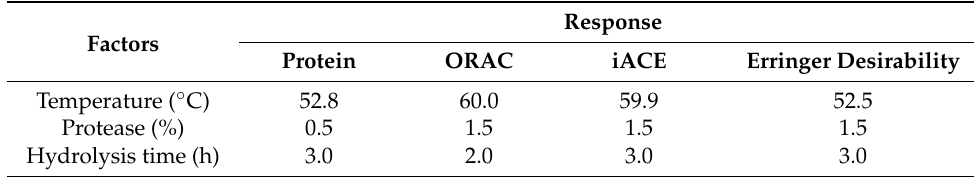
Table 5. Optimal conditions predicted by the experimental design to maximise protein/peptide release and antioxidant and anti-hypertensive activities of the hydrolysates, and Derringer desirability to predict the optimal conditions for a multiple response.